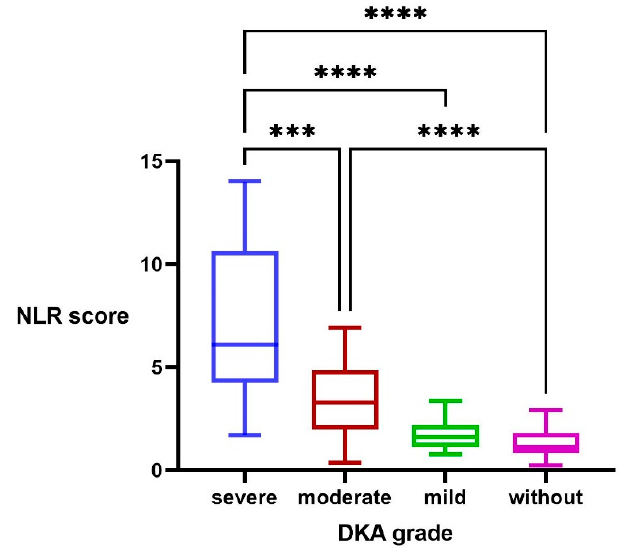
Figure 1. Univariate analysis with post hoc procedure regarding NLR scores in DKA patients; **** p = 0.000, *** p = 0.002.